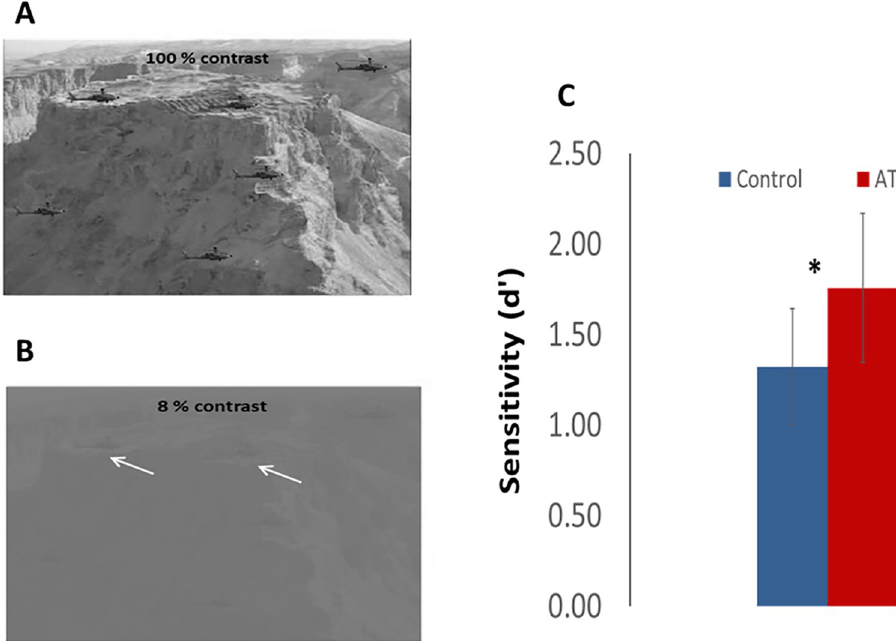
Fig 4. Detecting camouflage. (a) . An example of one aerial image used by our custom software at a contrast of 100% (not used in the test) and the same image (b) with 8% contrast (the highest contrast used for testing). (c) . Mean sensitivity (d’) for the 5 images. Sensitivity was calculated per subject per image and then averaged for each group. Aerial view of Masada (Andrew Shiva/Wikipedia/CC BY-SA 4 . 0)